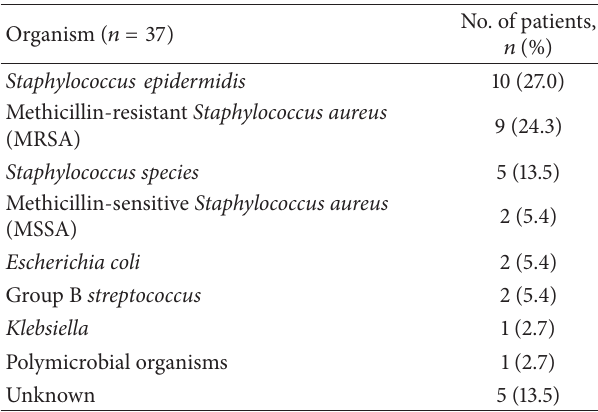
Table 1: Details of the causative organisms of infection in the 37 hips during the first-stage revision